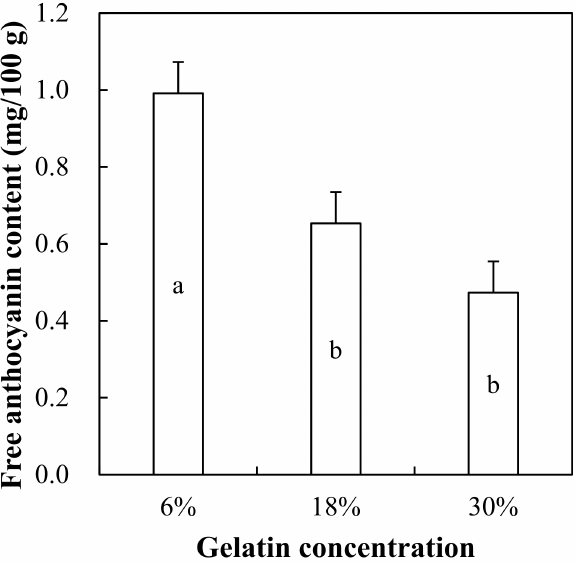
Figure 5. Free anthocyanin content of 6%, 18%, and 30% gelatin gels formulated with red maple leaf extracts (1000 mg/L). Error bars represent standard error of the means. a,b Means with the same letter are not significantly different ( p ≥